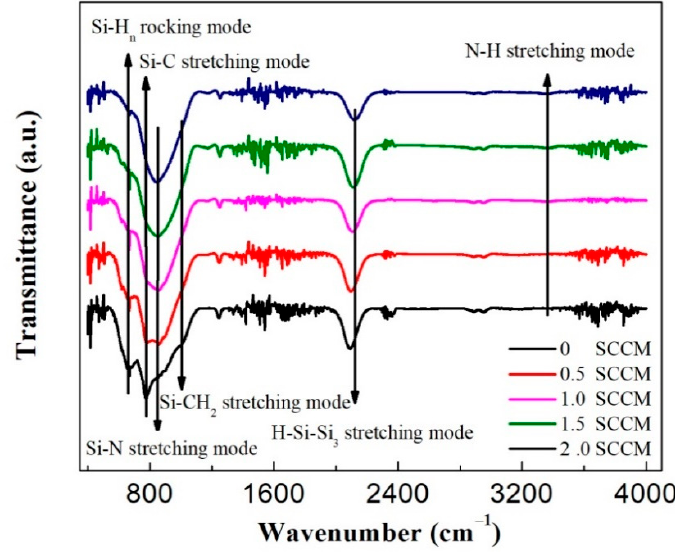
Figure 4. FTIR absorption spectra of the films prepared at different NH 3 flow rates.